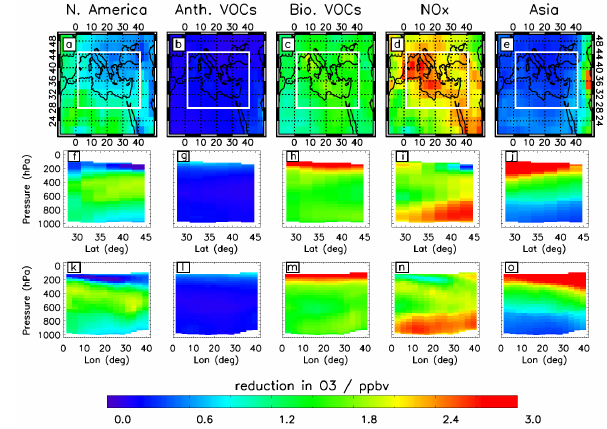
Fig. 5. Reduction in mean summertime (JJA) ozone (ppbv) resulting from a 20% reduction in four local precursor species emissions (from left to right: anthropogenic VOC, biogenic VOC, NOx and biomass burning). The top row shows the reduction is surface level ozone over the Mediterranean region. The middle row shows zonal mean ozone reductions within the white boxes depicted in the maps on the top row. The bottom row shows meridional means of the ozone reduction, also within the white boxes. For zonal and meridional mean plots, only tropospheric model grid boxes are plotted (determined as where potential temperature < 380 K and PVU <2).